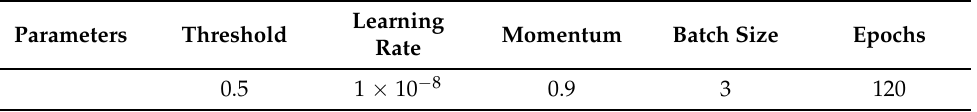
Table 1. Experiments